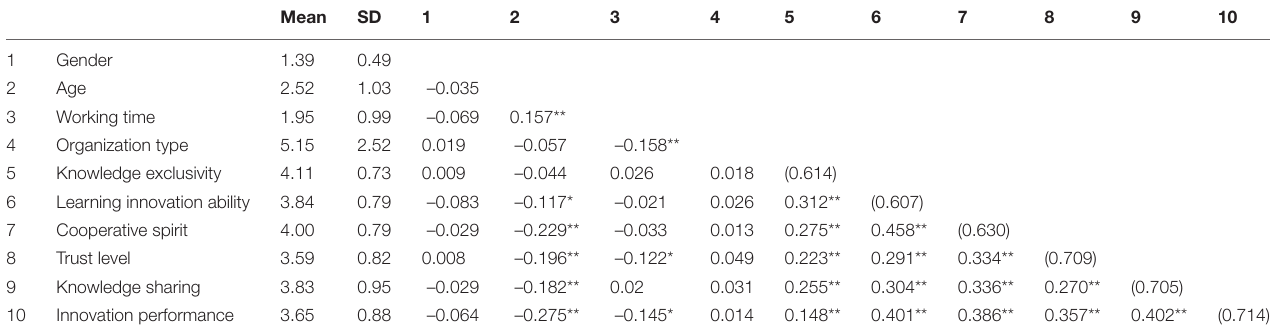
TABLE 1 | Correlation analysis and reliability test results of each variable.